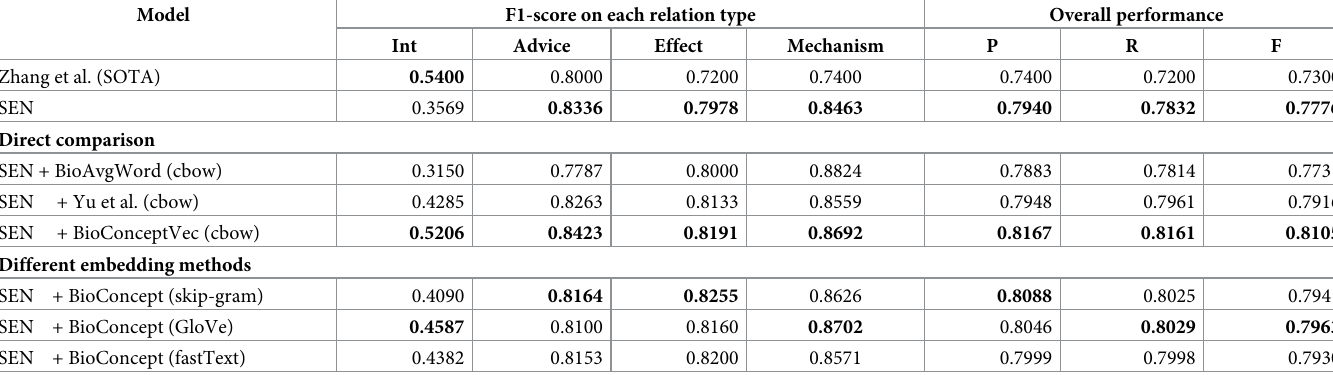
Table 7. Classification results of DDI classification. SOTA: state-of-the-art. P: Precision. R: Recall. The SOTA results are extracted from [63]. Direct comparison: the results of embeddings using the same method (cbow) and same hyperparameters. Different embedding methods: the results of BioConceptVec (skip-gram), BioConcept- Vec (GloVe) and BioConceptVec (fastText). The highest results of each section are marked as